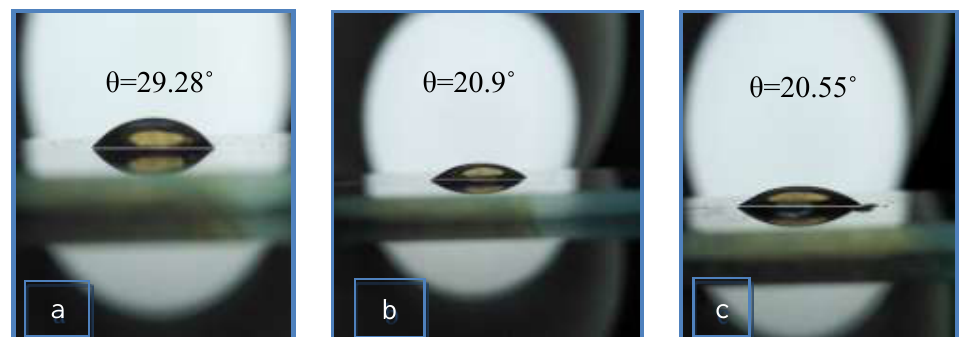
Fig.10b Images of water droplet on the sample pure TiO b- after15 min. of Vis irradiation c- an hour Vis irradiation. Table 3: Contact angle of Mn-doped TiO